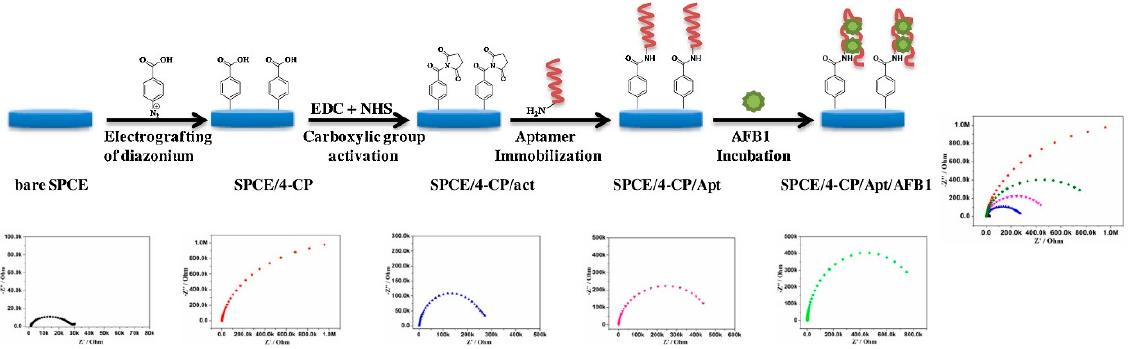
Figure 8. Schematic representation of the electrode fabrication. Reproduced from [22]. Copyright 2017 Elsevier.